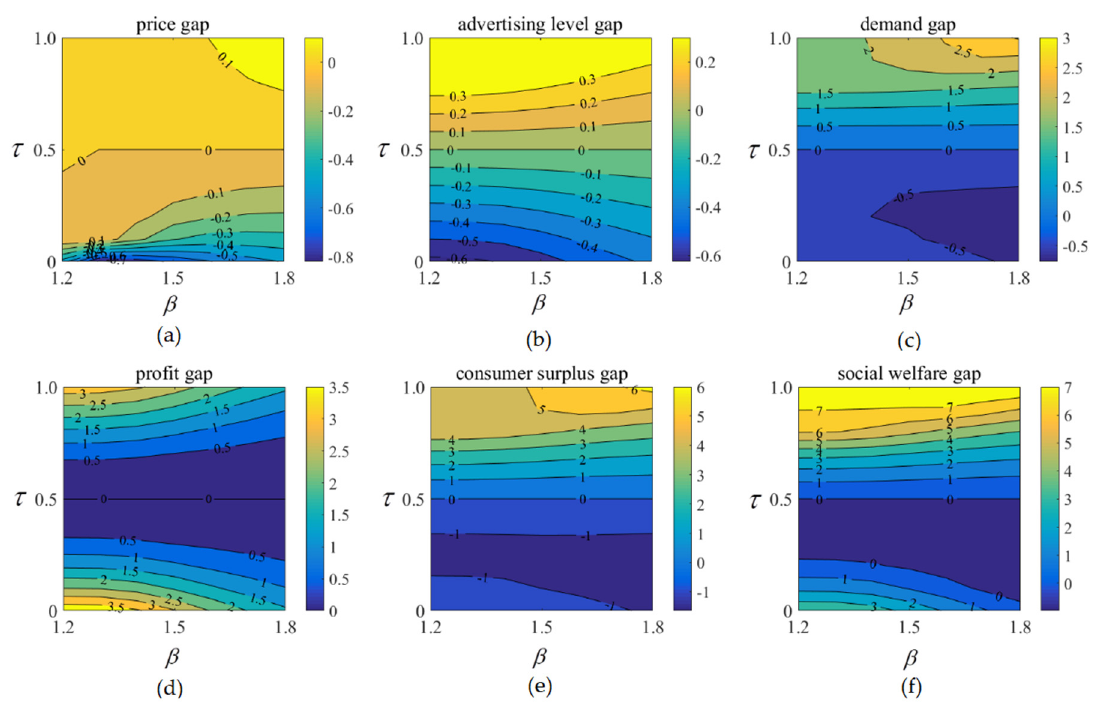
Figure 4. Contour plots on the effects of proximity technologies: ( a ) the effect on the price gap; ( b ) the effect on the advertising level gap; ( c ) the effect on the demand gap; ( d ) the effect on the profit gap; ( e ) the effect on the consumer surplus gap; and ( f ) the effect on the social welfare